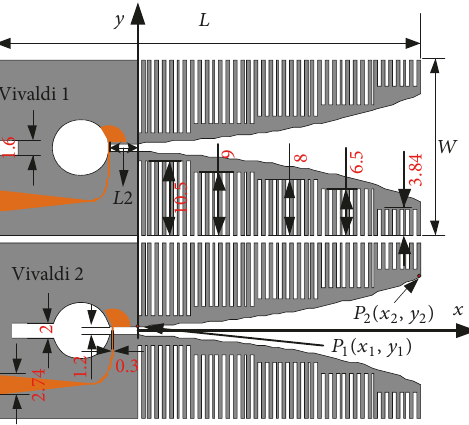
Figure 1: Geometry of the designed antenna elements: Vivaldi 1 and Vivaldi 2. Dimensions are in mm.